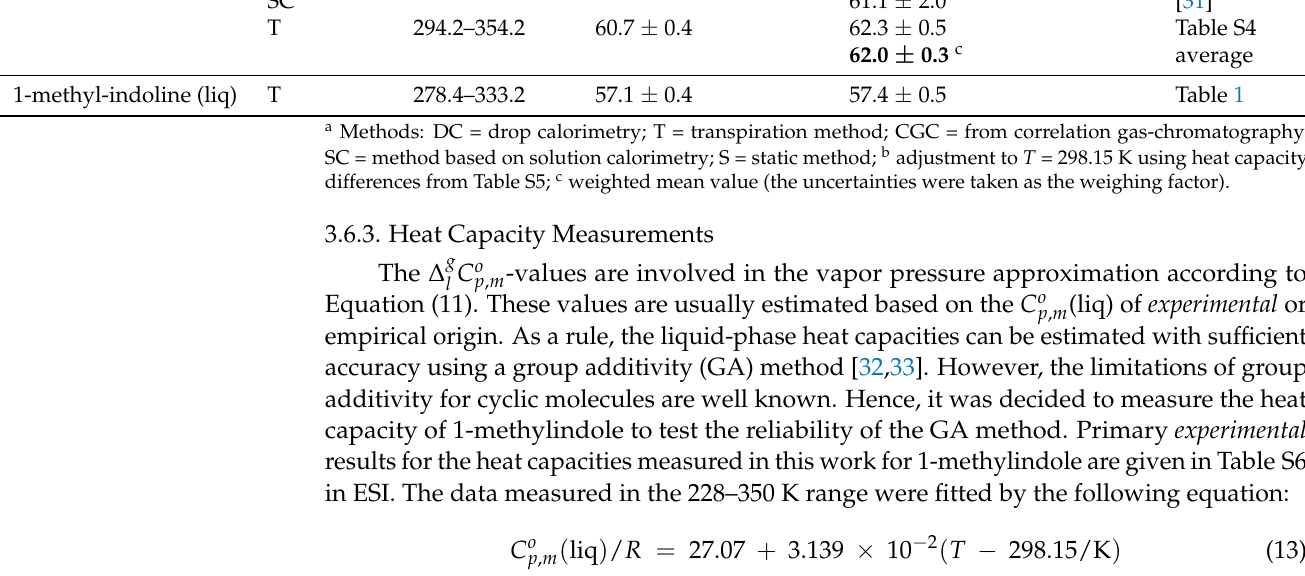
a Methods: DC = drop calorimetry; T = transpiration method; CGC = from correlation